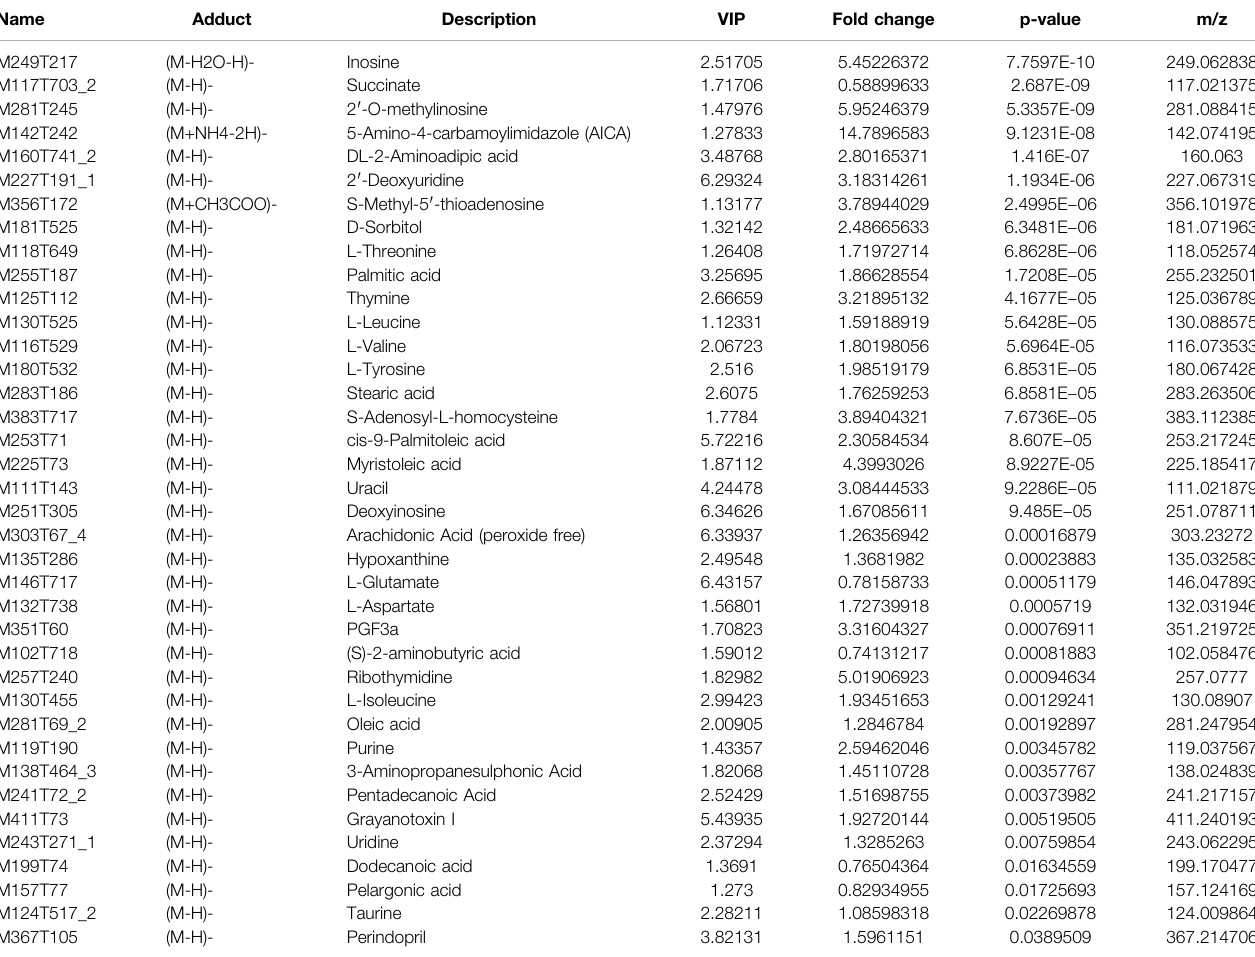
TABLE 4 | 38 signi fi cantly different metabolites in negative ion